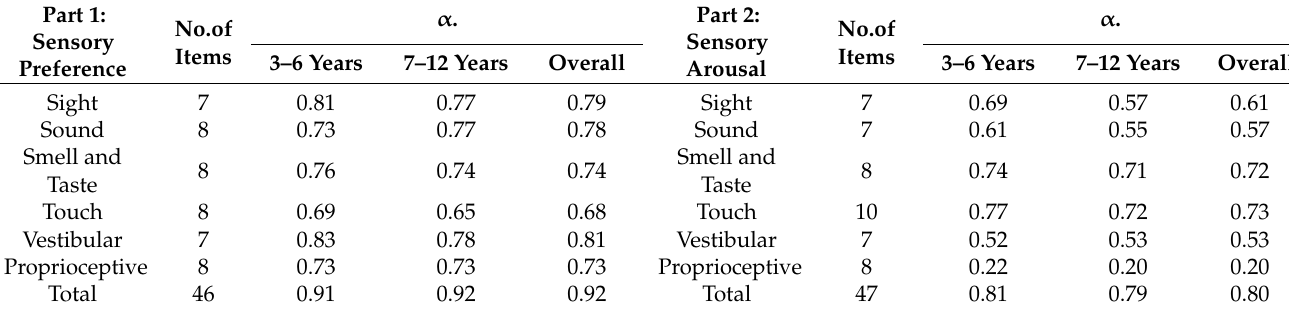
Table 1. Internal consistency estimates of the TSPA before factor analysis ( n = 414).